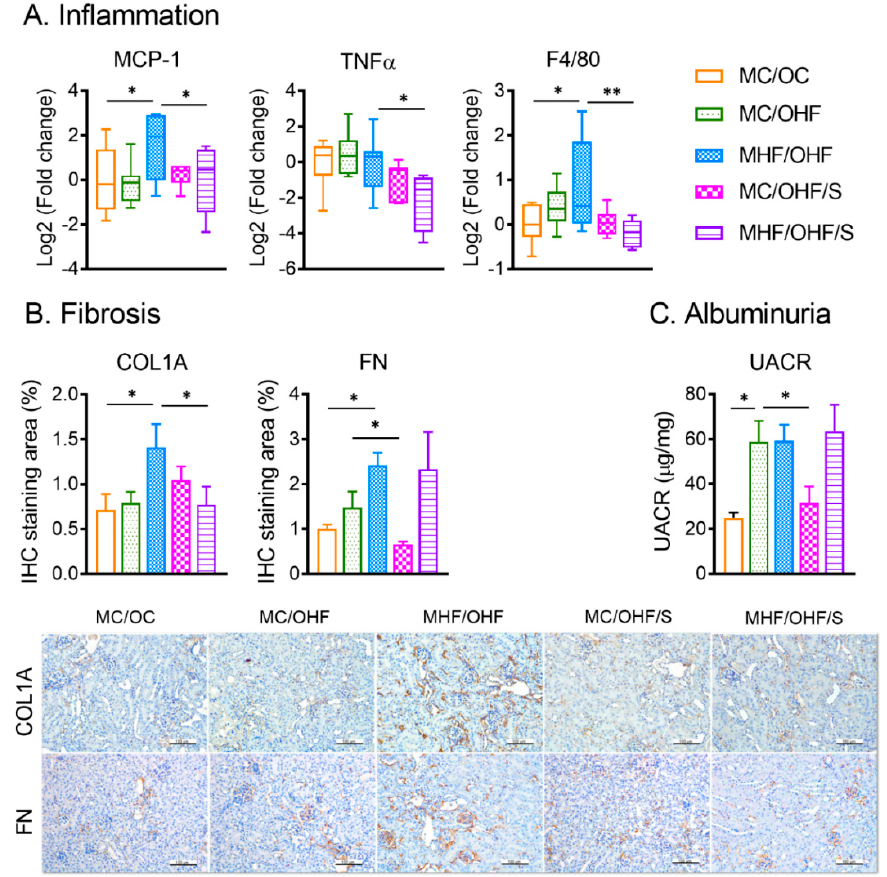
Figure 7. SRT1720 attenuates renal inflammation and fibrosis but not the urinary albumin creatinine ratio in offspring due to maternal and postnatal HFD consumption. ( A ) mRNA expression of inflammatory markers. ( B ) Immunohistochemistry quantification of fibrotic markers ( n = 8). ( C ) Urinary albumin creatinine ratio UACR ( n = 8). Data are presented as mean ± SEM. MCP: Macrophage chemotactic protein; TNF α : Tumour necrosis factor alpha; COL: collagen; FN: fibronectin. MC: offspring of chow-fed dams; OC: chow-fed offspring; MHF: offspring of HFD-fed dams; OHF: HFD-fed offspring; S: SRT1720. * p < 0.05, ** p < 0.01.